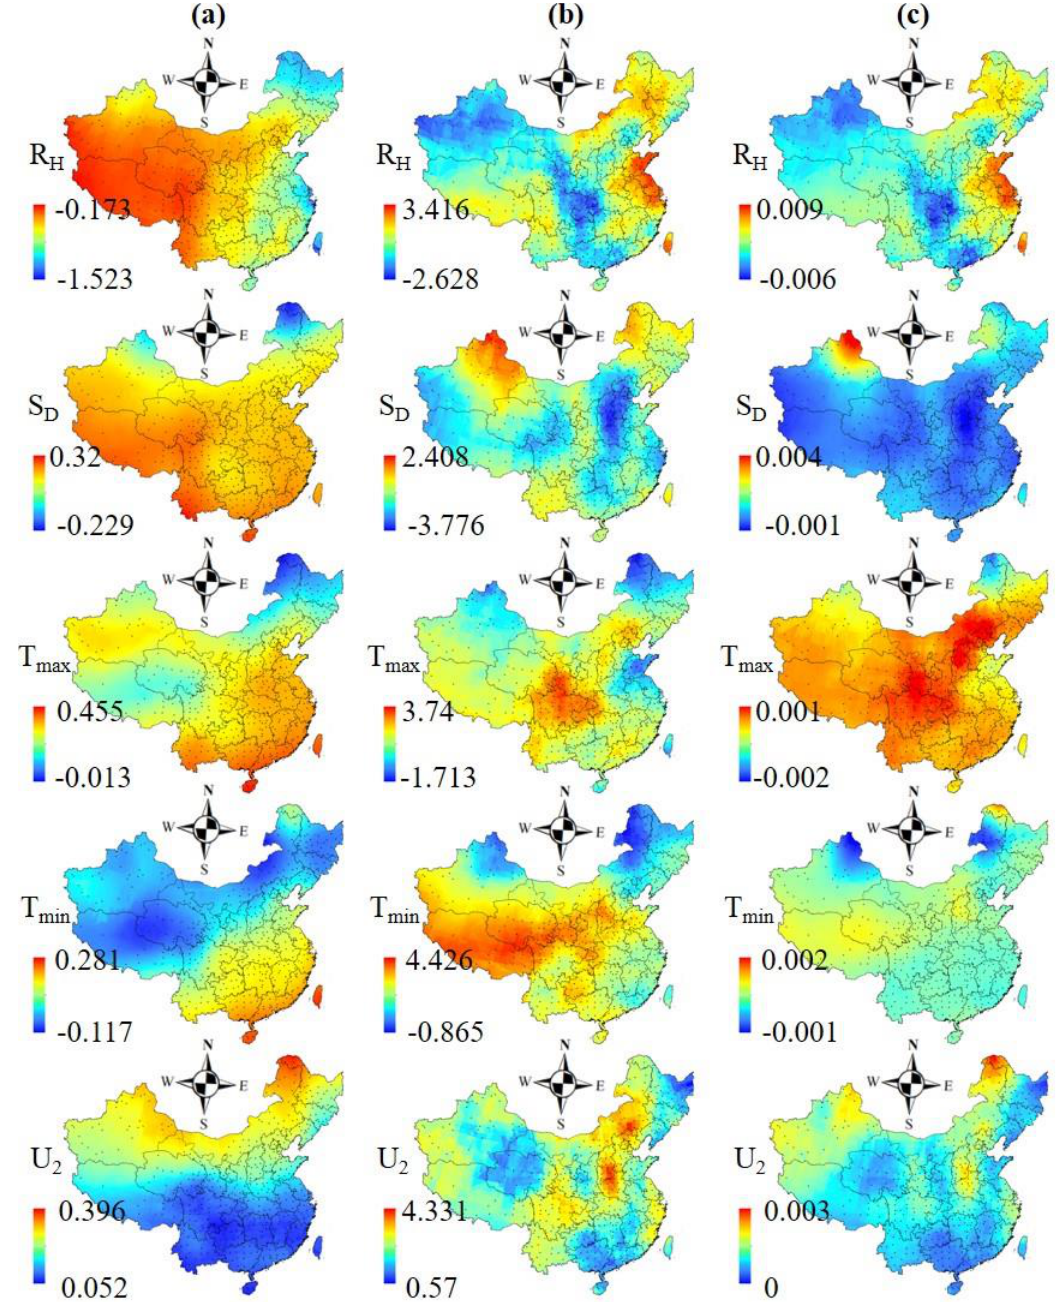
Figure 9. Sensitivity coefficients for the climatic factors: ( a ) mean; ( b ) M – K Z s ; and ( c ) Sen’s slope